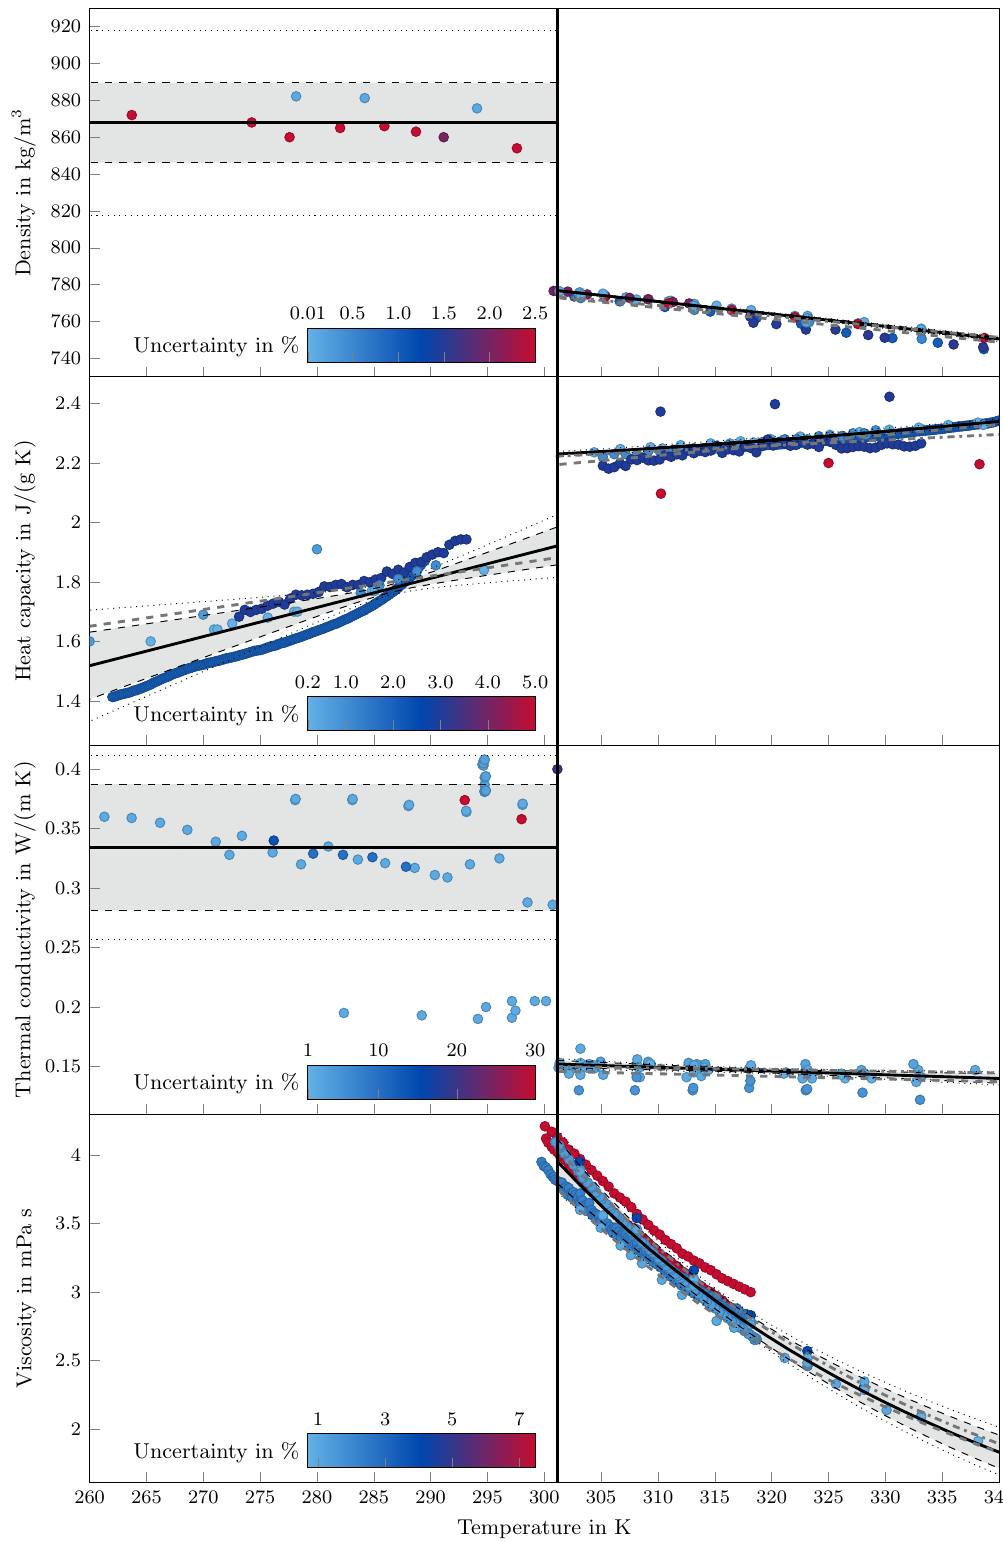
Figure 6. Summary of the estimated fit functions for the temperature-dependent thermophysical properties of octadecane. The displayed points indicate the preselected data applied for the calculation and the color scale corresponds to the associated uncertainty. The grey shaded areas between the dashed lines describe the confidence interval of 95% and the dotted lines a confidence of